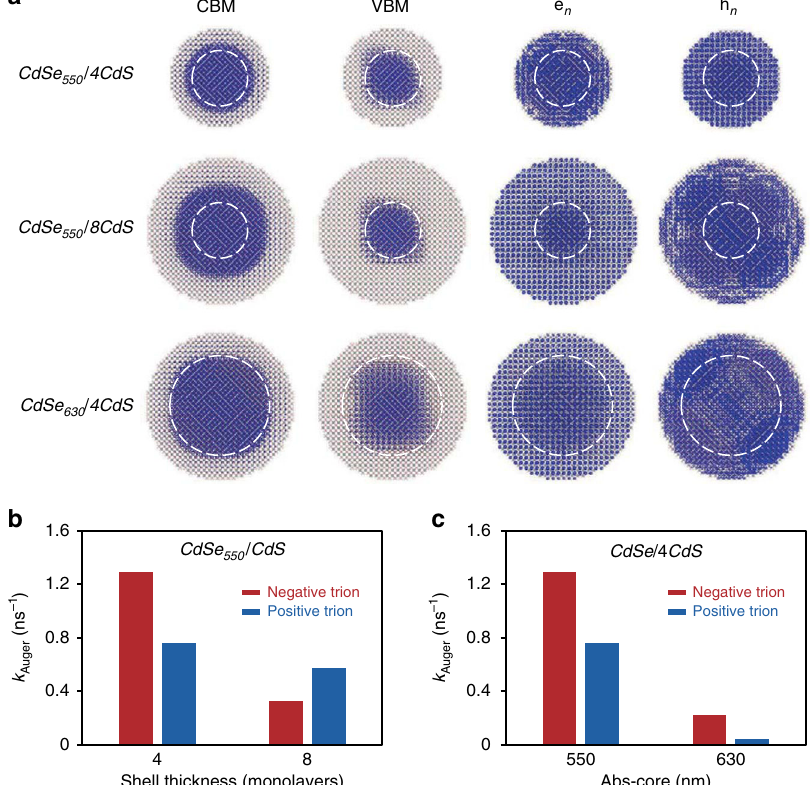
Fig. 5 Snapshot of the charge density and the theoretical calculation results. a The charge density of the conduction band minimum (CBM), valence band maximum (VBM), and averaged e n and h n states for CdSe 550 /4CdS quantum dots (QDs), CdSe 550 /8CdS QDs and CdSe 630 /4CdS QDs. b The theoretical calculation results of the Auger recombination rates for negative and positive trions for CdSe/CdS core/shell QDs with the same core size but different shell thicknesses. c The theoretical calculation results for the Auger recombination rates for negative and positive trions for CdSe/CdS core/shell QDs with the same shell thickness but different core